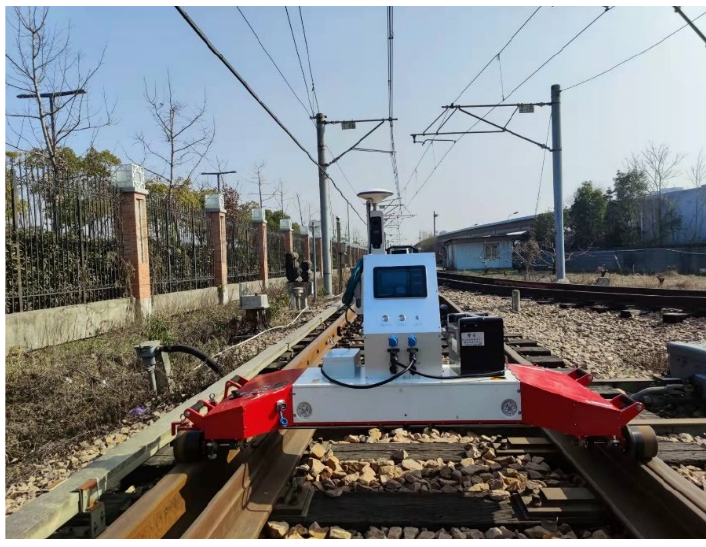
Figure 11. Mobile laser scanning system in experiment environment.